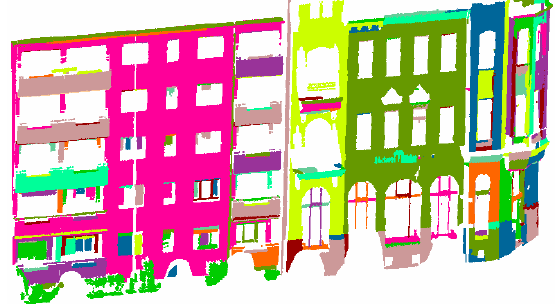
Figure 7. Segmentation results – Case 2 (the different features are denoted by different colours) In planar segmentation, surface roughness of points is assisted for the correct recognition of seed segments. As a result,